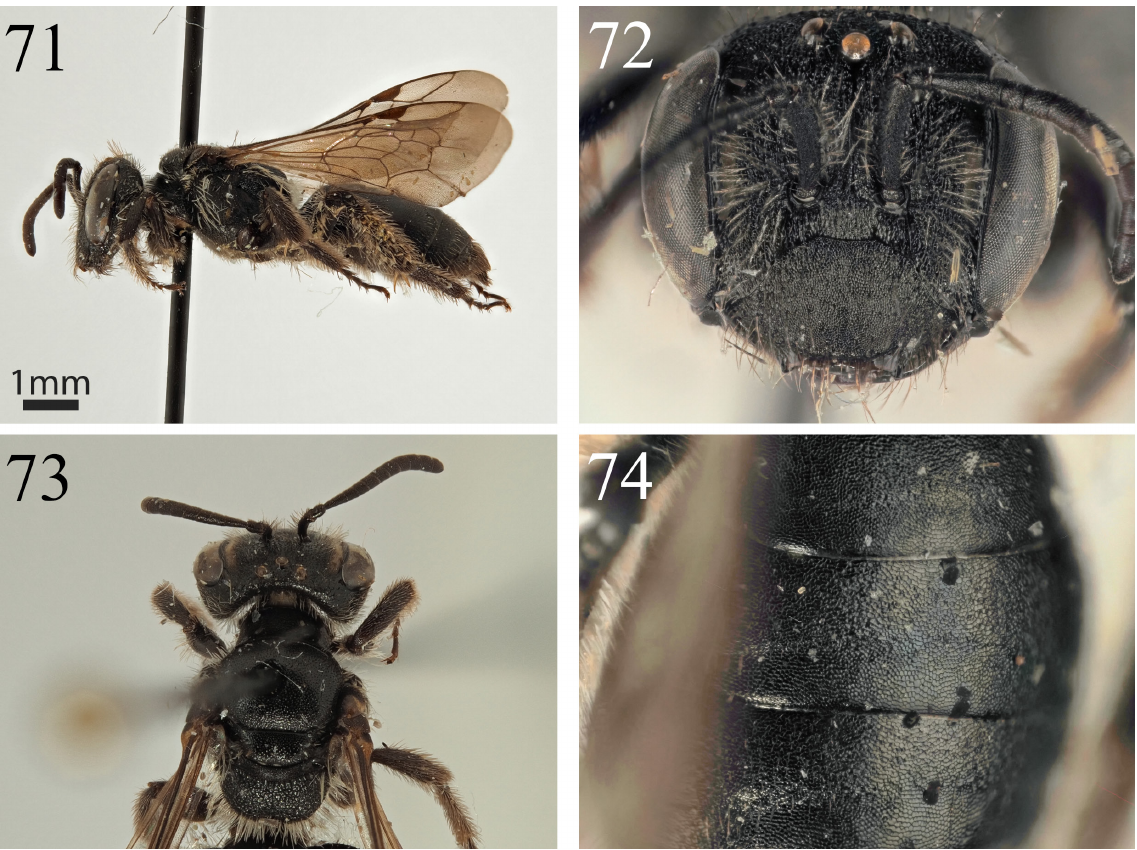
Figs 71–74. Andrena tabula Wood sp. nov., ♀ (OÖLM). 71 . Profile. 72 . Face. 73 . Dorsum. 74 .